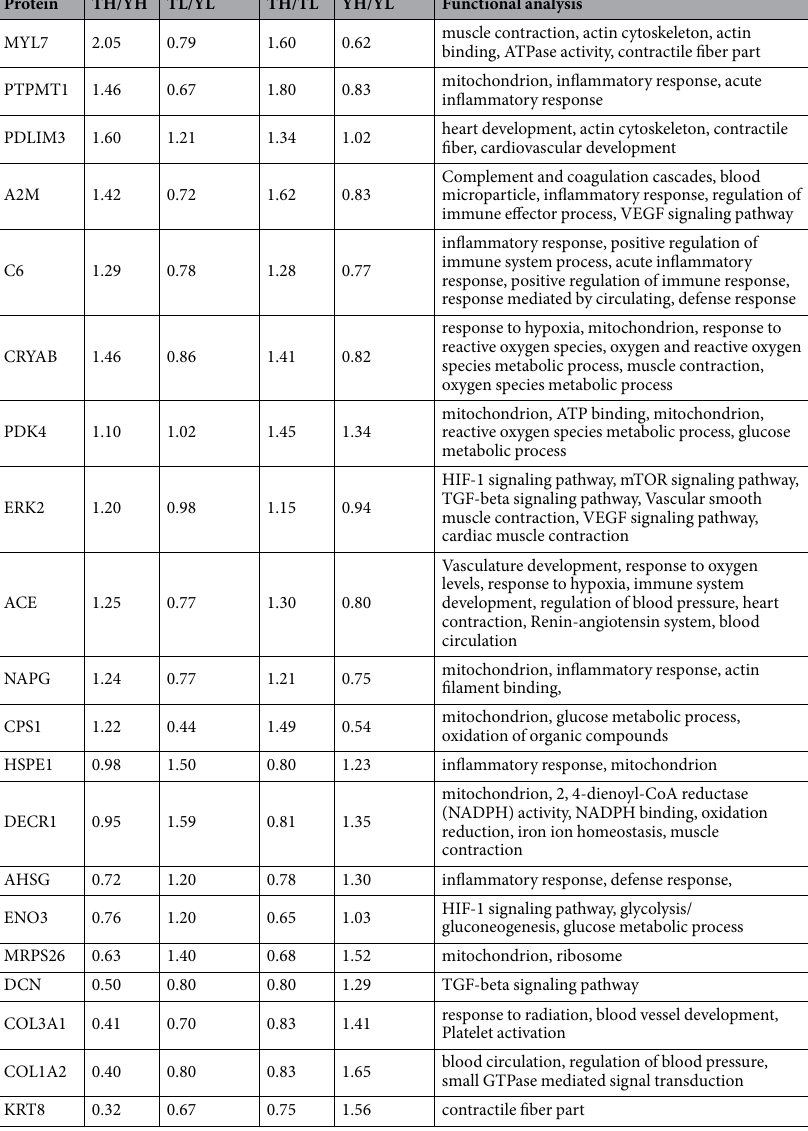
Table 2. Summary of hypoxia-regulated differentially expressed proteins (DEPs). TH, Tibetan highland pig; TL, Tibetan lowland pig; YH, Yorkshire highland pig; YL, Yorkshire lowland